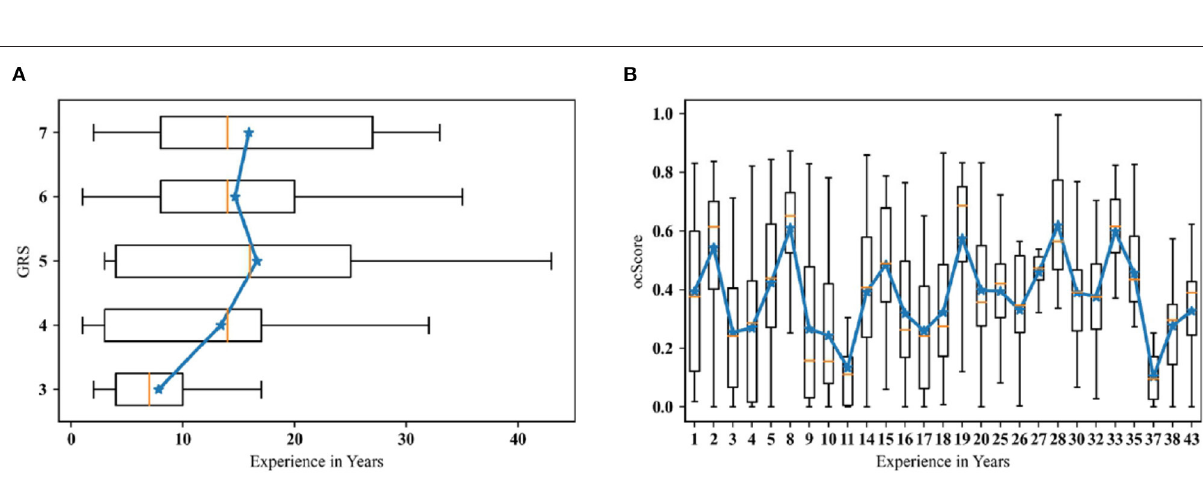
Frontiers in Medicine |